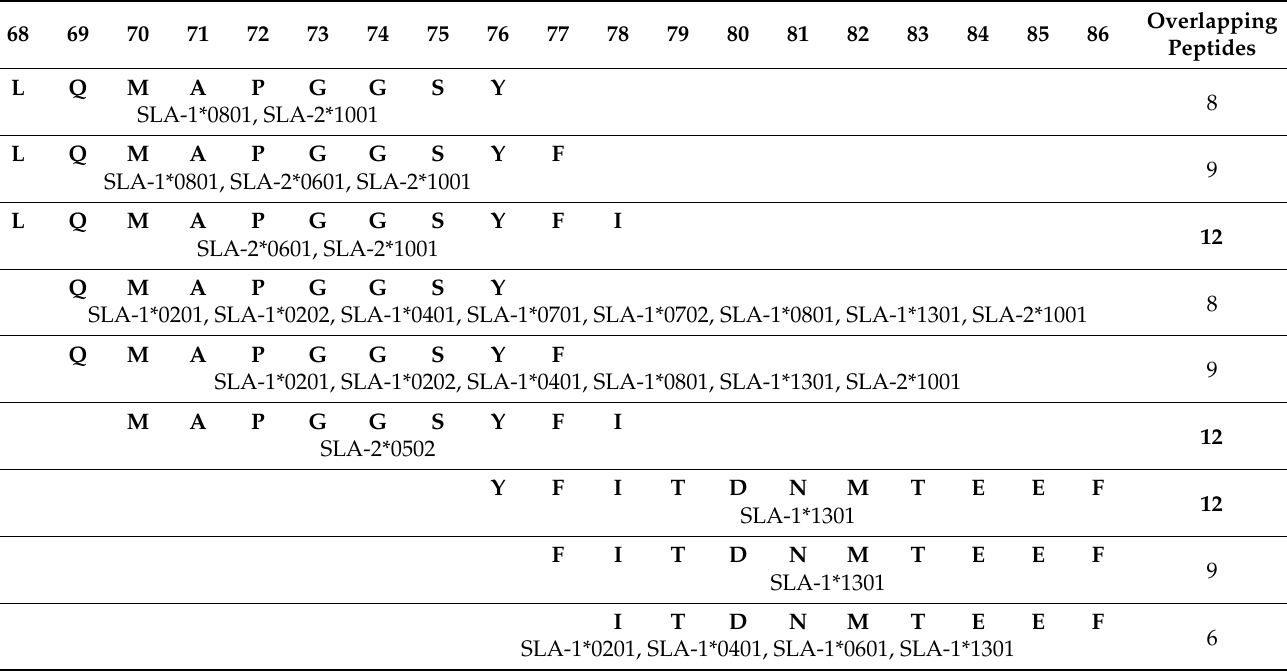
Table 1. Predicted epitopes within the peptide MGF100-1L 68–86 (LQMAPGGSYFITDNMTEEF). The table summarizes the number of predictions that overlap with each sequence and the SLA I alleles predicted to present